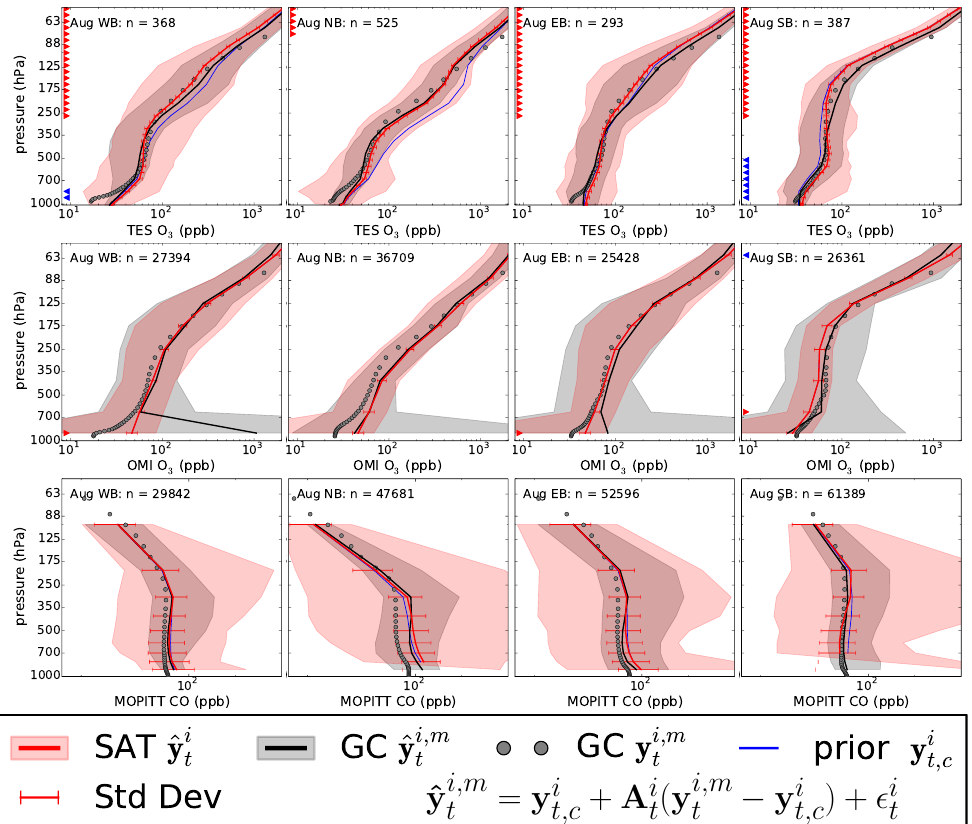
Fig. 4. same as Fig. 3 for August. Fig. 4. Same as Fig. 3 for